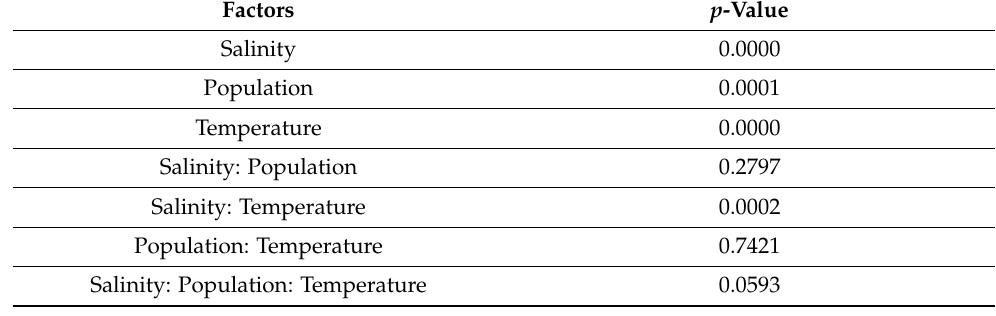
Figure 1. Final germination percentages (FGP) of D. stramonium at different temperature ranges and salinity levels (data from the two populations were averaged). Vertical bars represent the standard errors.